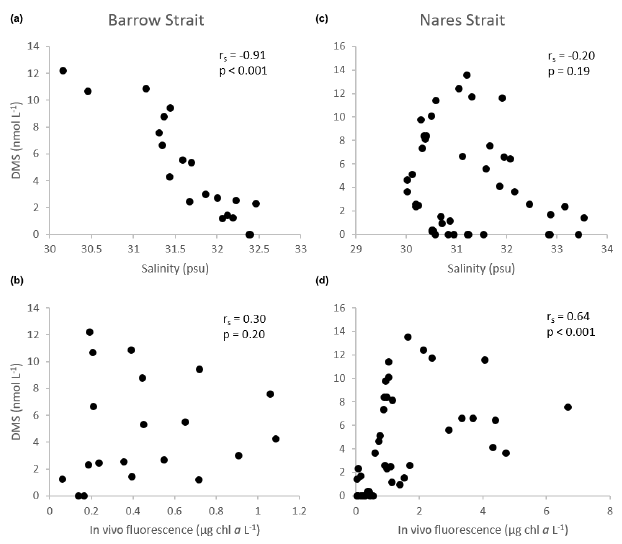
Figure 9. Scatter diagrams of DMS, as a function of salinity and in vivo fluorescence, in the upper ca. 100m of the water column in the Barrow Strait transect ( n = 20) in (a) and (b) and the Nares Strait transect ( n = 44) in (c) and (d) . r s : Spearman’s rank correlation.